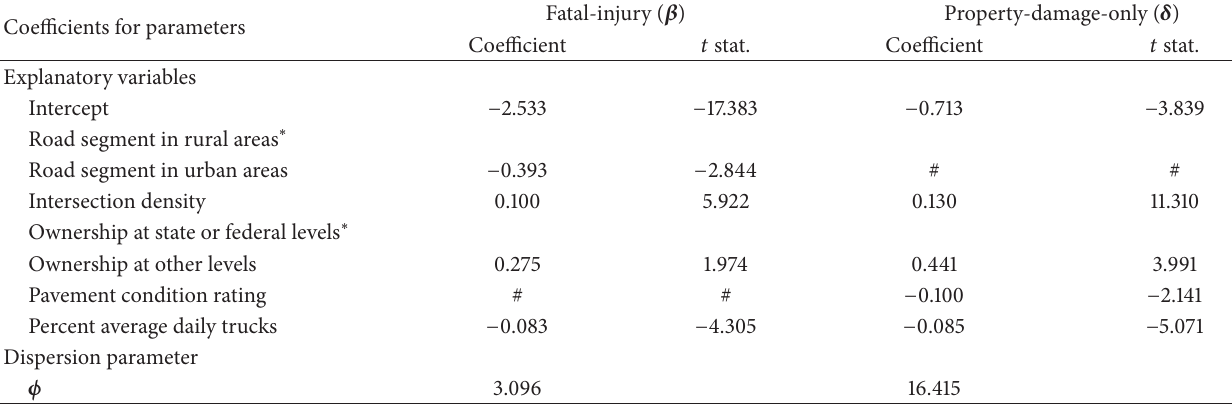
Table 2: Estimation results for the quasi-Poisson